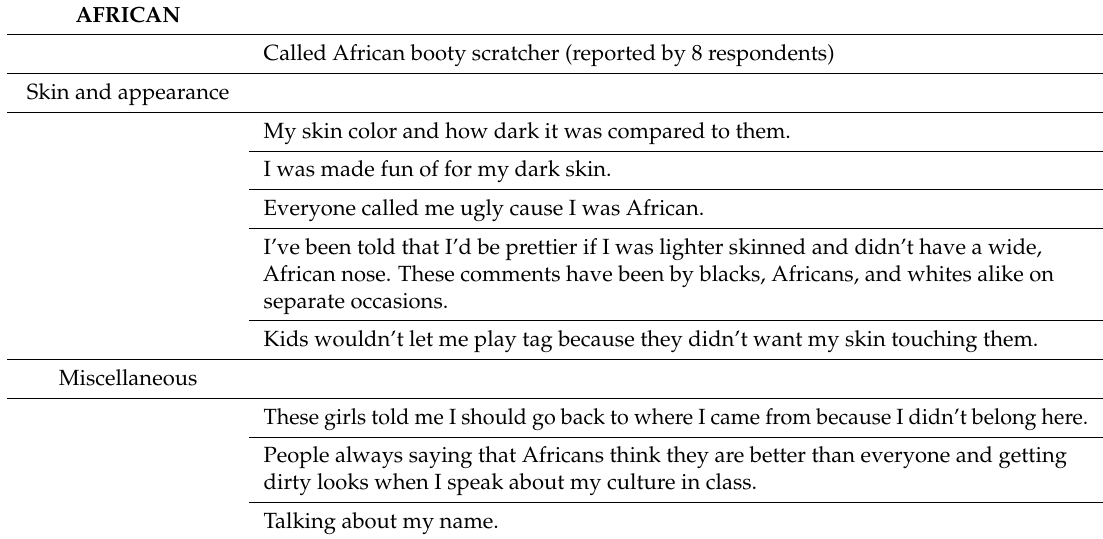
Table A1. Written Comments from Qualtrics